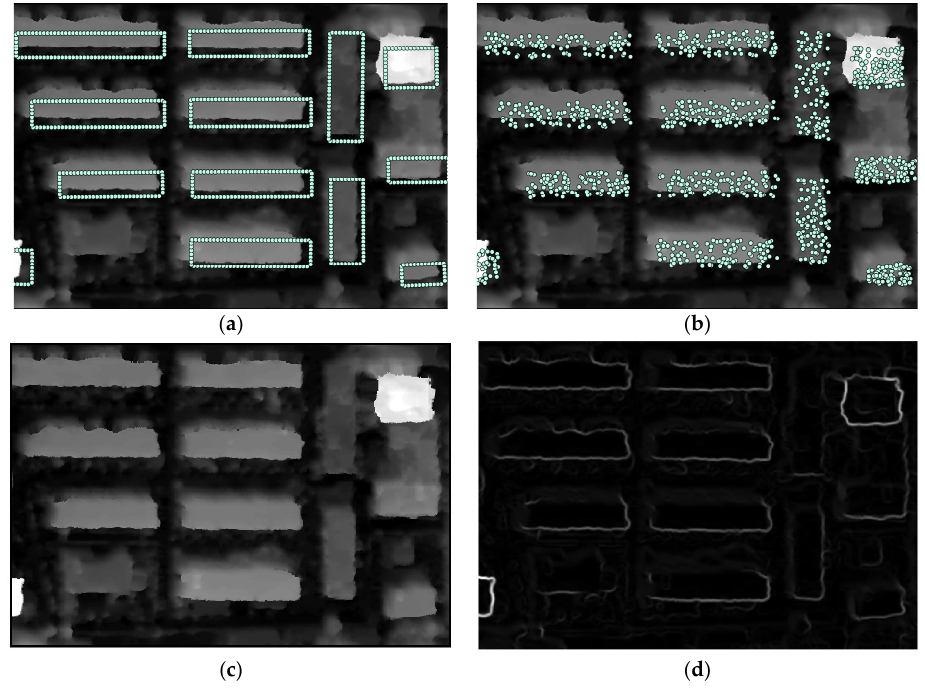
Figure 2. The inputs of the coarse registration in an experimental area in Beijing , including ( a ) dis- crete boundary points of OSM, ( b ) discrete interior points of OSM, ( c ) DSM and ( d ) the corresponding gradient map.